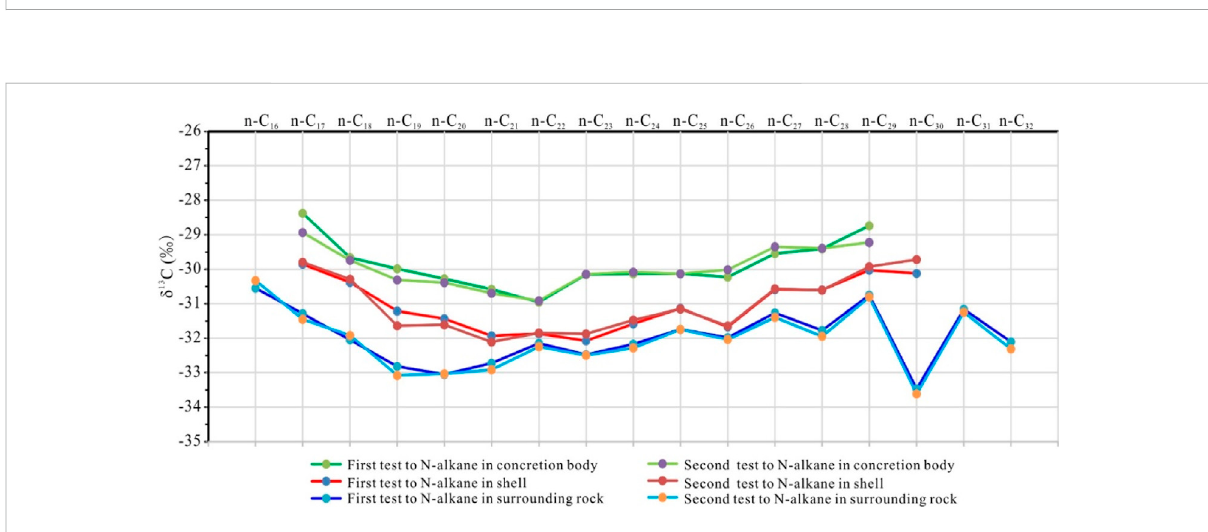
FIGURE 12 Gas chromatography-isotope ratio mass spectrometry results showing the δ 13 C of n -alkanes.